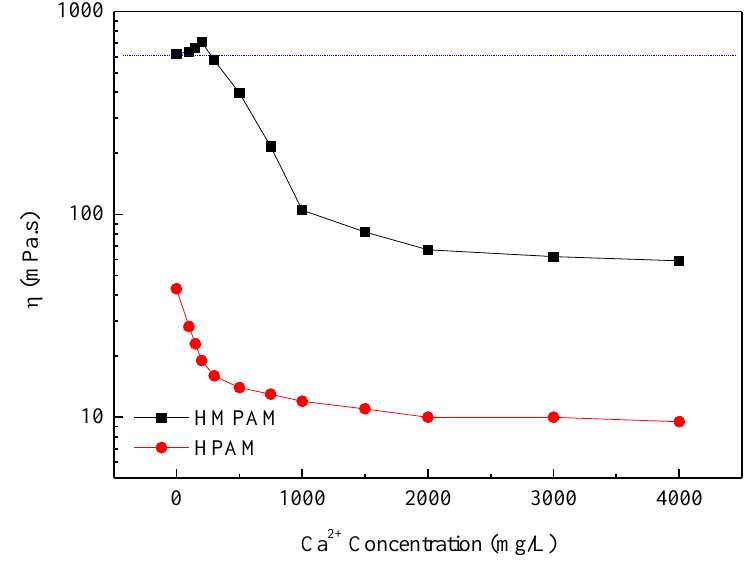
Figure 3. The apparent viscosity of polymer solutions with 1500 mg/L versus Ca 2+ concentration at 45 ◦ C. As shown in Figure 4, HMPAM demonstrated better temperature resistance performance compared with HPAM. Temperature has two effects on the HMPAM viscosity; namely exothermic hydrophobic hydration and endothermic hydrophobic-hydrophobic interaction. As a result of these two effects, the viscosity of HMPAM decreased smoothly from 25 to 55 ◦ C, while HPAM viscosity decreased sharply with the increasing temperature